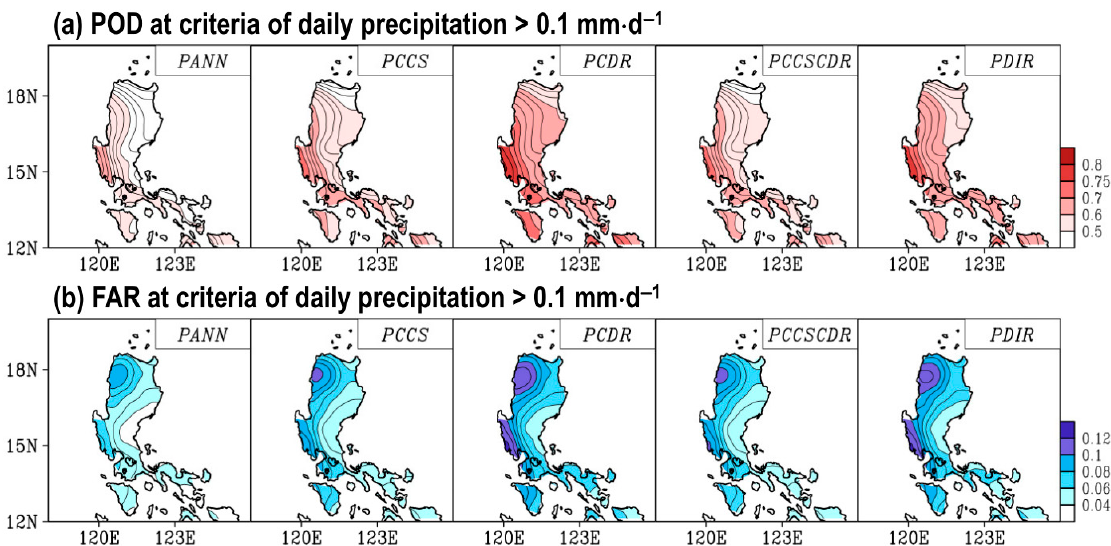
Figure 11. ( a ) The spatial distribution of POD at criteria of daily precipitation of >0.1 mm · d − 1 from 2013–2015 over Luzon; and ( b ) as in ( a ), but for FAR. The contour intervals in ( a ) and ( b ) are 0.025 and 0.01, respectively.